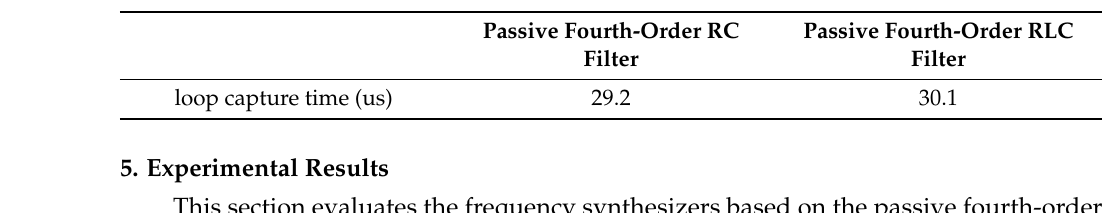
Table 5. Loop capture time simulation results.